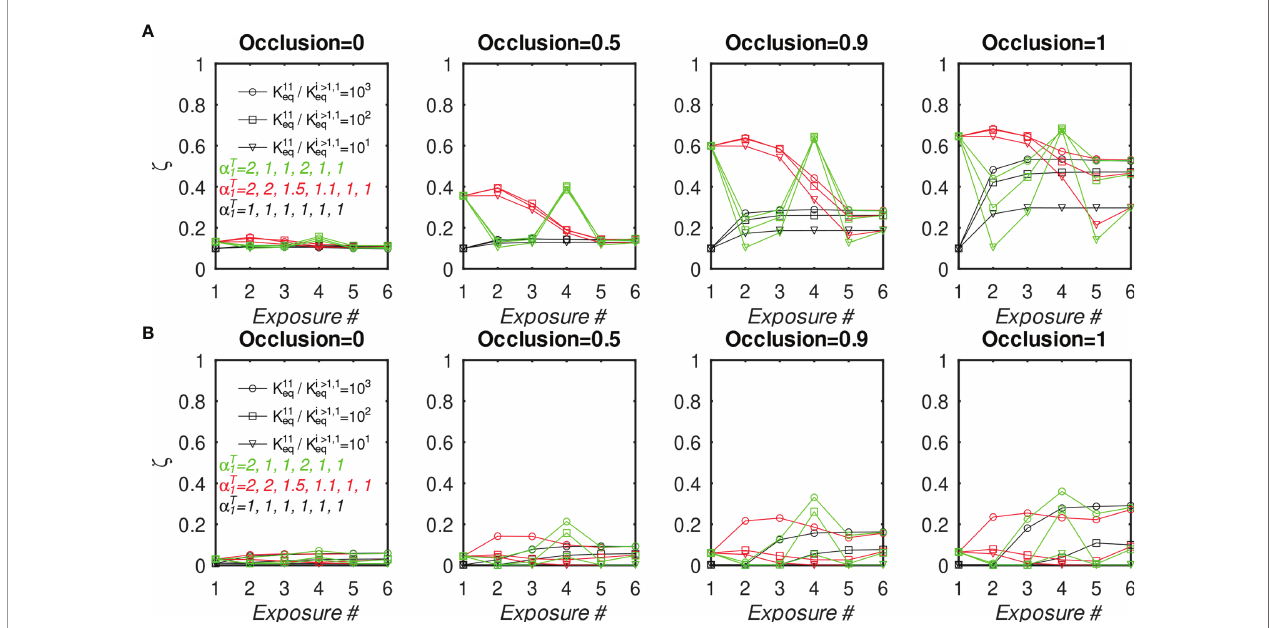
FIGURE 8 | Fraction of MBC#1 vs. number of sequential GC simulations for different initial af fi nity advantage values and different Ag#1 concentrations, with 10 total BCR/Epitope pairs. (A, B) MBC#1 fraction ( z ) at the end of simulations. (A) BCR#1 is cooperatively bivalent (K 12 eq =10K 11 eq ); (B) BCR#1 is monovalent (K 12 eq =0). The four sets of panels (A, B) show the effect of increasing occlusion from o =0 (no competition) to o =1 (full